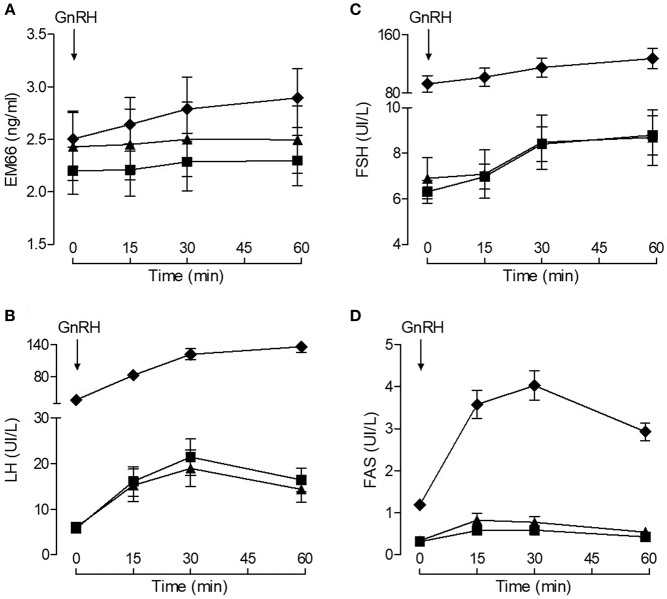
Plasma EM66 and gonadotropin levels of healthy women during stimulatory condition of the reproductive axis. Results of dynamic test for evaluation of EM66 (A), LH (B), FSH (C), and FAS (D) levels in plasma of healthy women. Response of EM66 and gonadotropins after intravenous administration of 100 μg GnRH in premenopausal women without (■) or with (▴) oral contraception or in postmenopausal women (♦). Values are means ± SEM (n = 8).